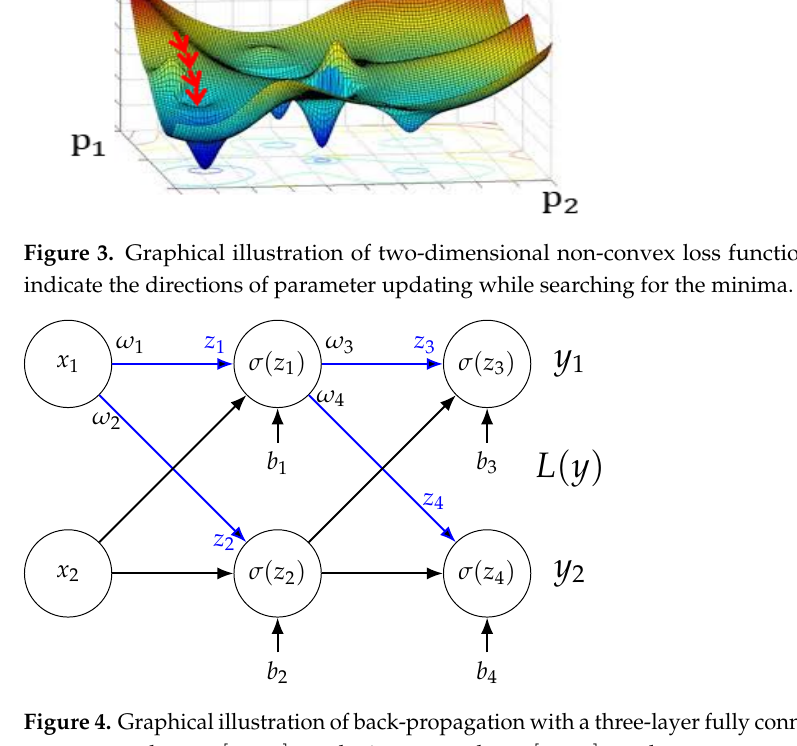
) is the σ ( z 1 ) + ω 4 σ ( z 2 ) + b 3 . In addition, σ ( · · · ∂ y 1 ∂ z 3 = ∂ L ( y ) = ∂ L ( y ) , ∂ L ( y ) . ∂ L ( y ) is the gradient of the loss ∂ω 3 ∂ z 3 ∂ω 3 ∂ z 3 ∂ y 1 ∂ z 3 ∂ y 1 ∂ L ( y ) = σ (cid:48) ( z 3 ) , ∂ z 3 = σ ( z 1 ) . Therefore, ∂ L ( y ) = σ (cid:48) ( z 3 ) σ ( z 1 ) ∂ z 3 ∂ω 3 ∂ω 3 ∂ y 1 · ·